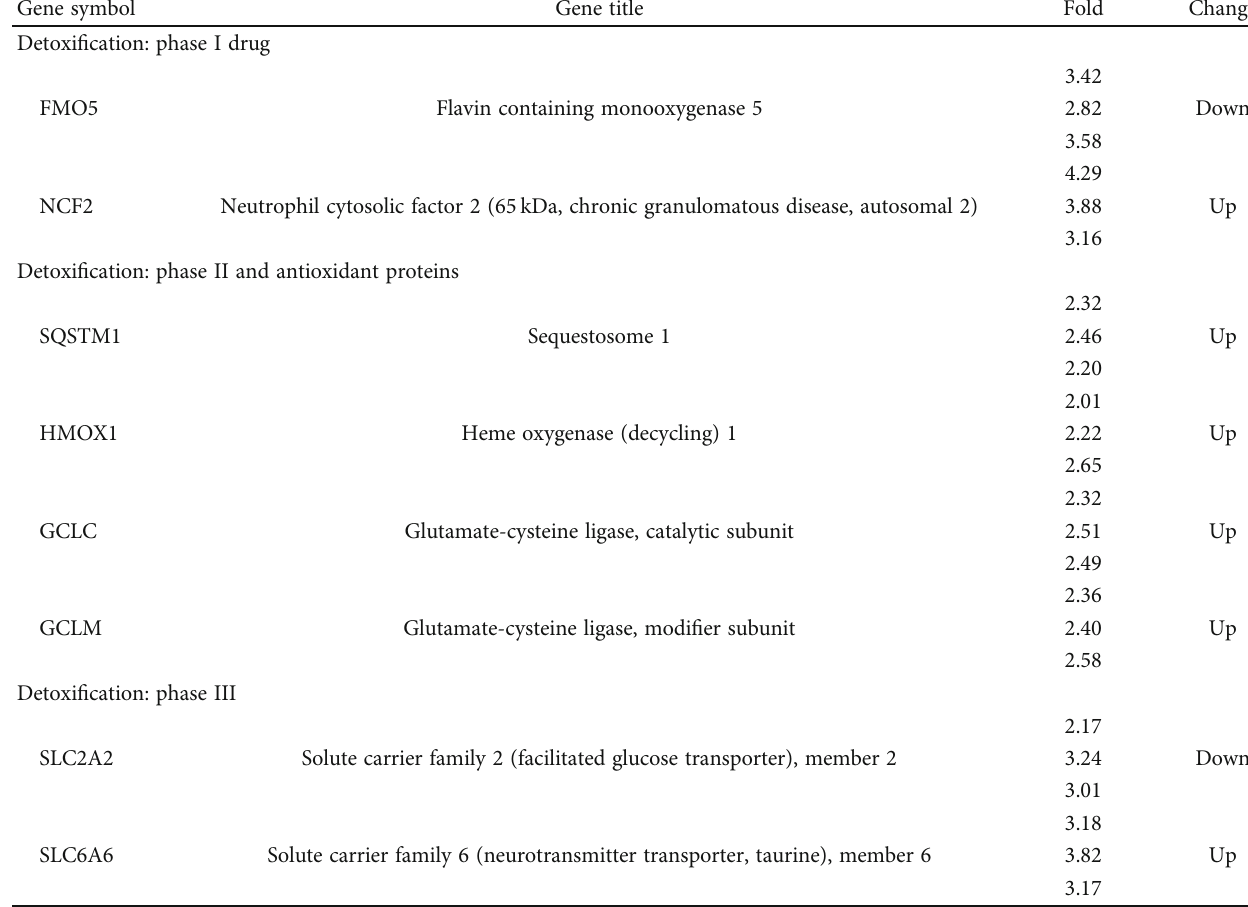
Table 2: Changes in gene expression of drug metabolizing enzymes and transporters in DSs-treated